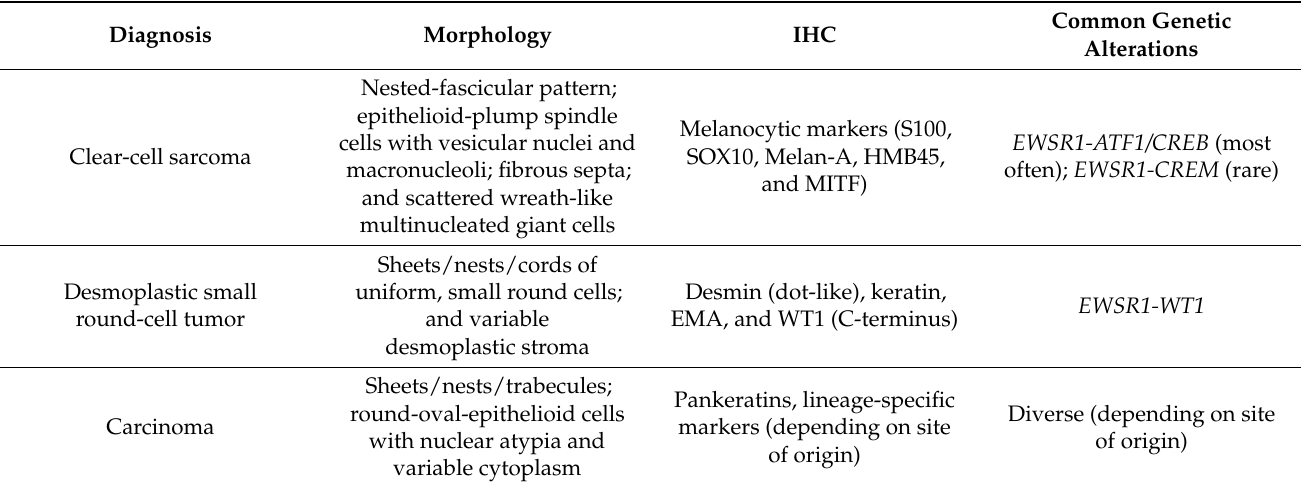
Table 8. Differential diagnoses of